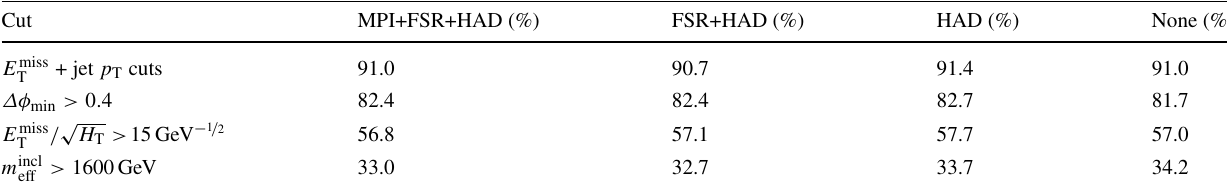
Table 6 Reproduction of the same ATLAS 0 lepton cutflow as Table 3, with each column representing different Pythia8 settings. The baseline in the final “None” column has tau spin correlations turned off (since they have no effect for SUSY models in any case), ISR turned on, and hadronisation (HAD), FSR and multiple parton interactions (MPI) turned off. Pythia8 is configured to produce light squark pairs only,